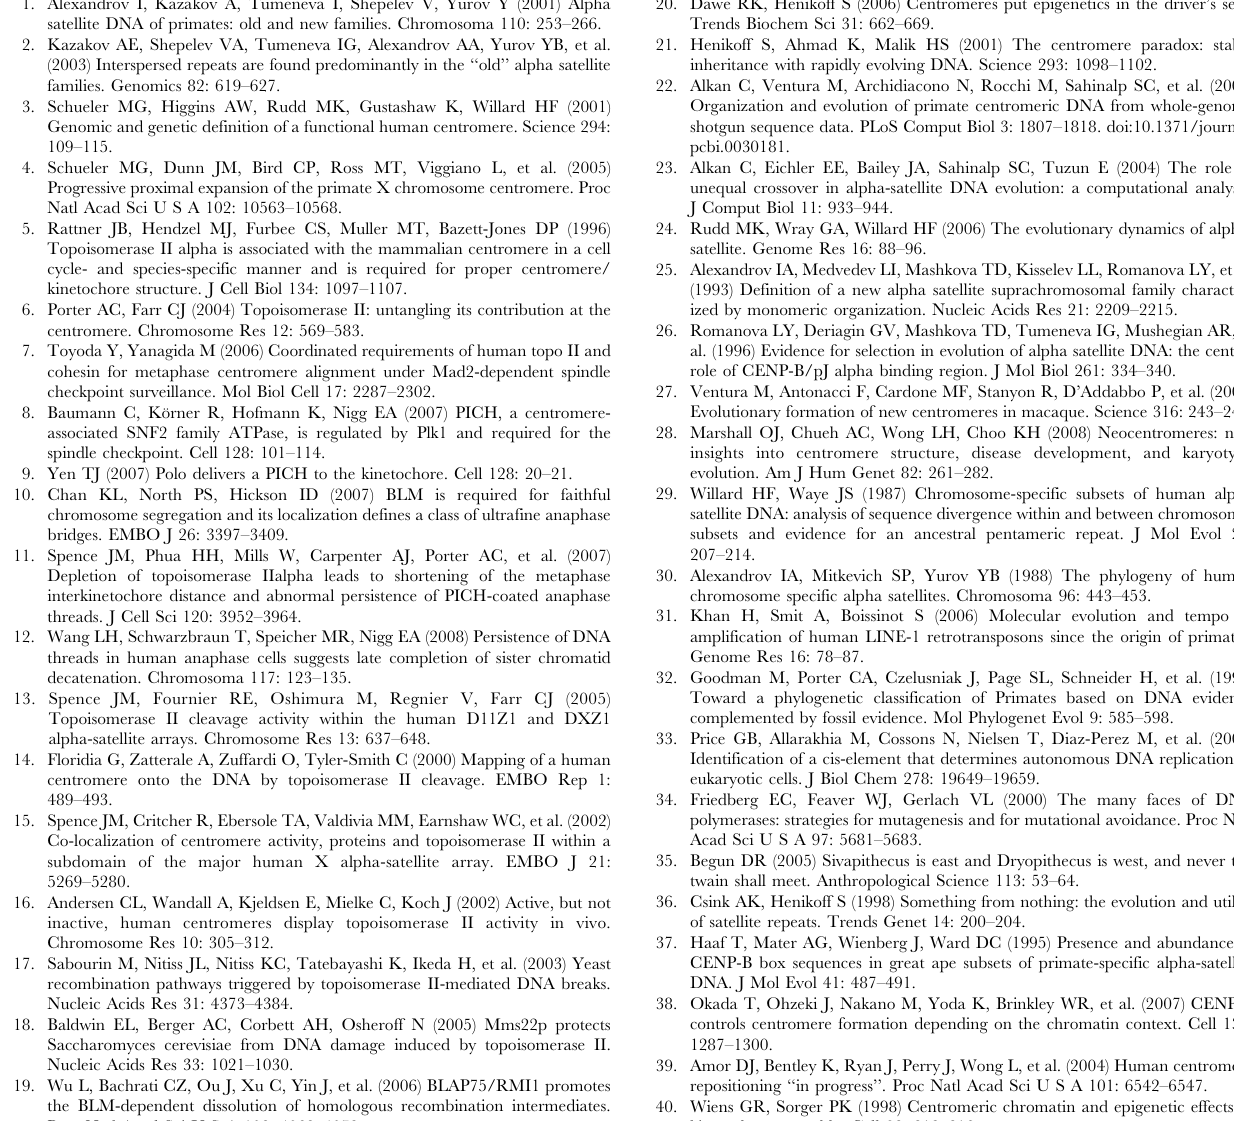
Table S6 Human sequences used in ‘‘additional’’ L1 scoring in Table S3 and reference sequences for primate AS